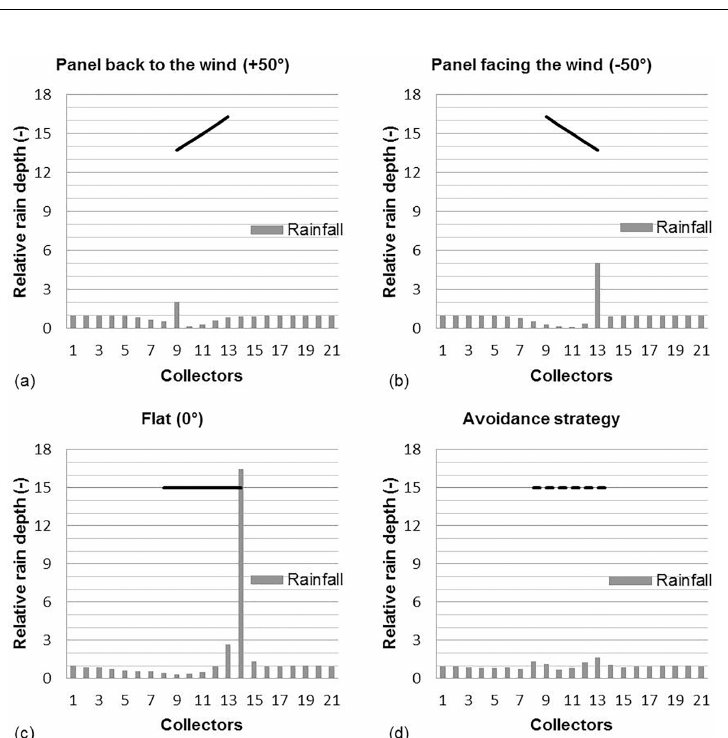
Figure 6. Examples of rain redistribution for various rain events, tilting angle and operating strategies of the solar panels, measured in the collectors displayed in Fig. 1. Relative rain depths are given with respect to the control zone where rain amounts are collected in the